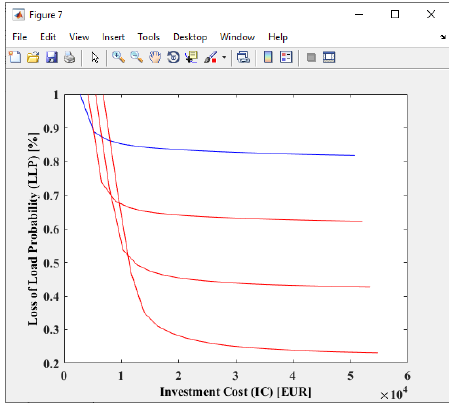
Figure 17. Irradiation and Load at average two years